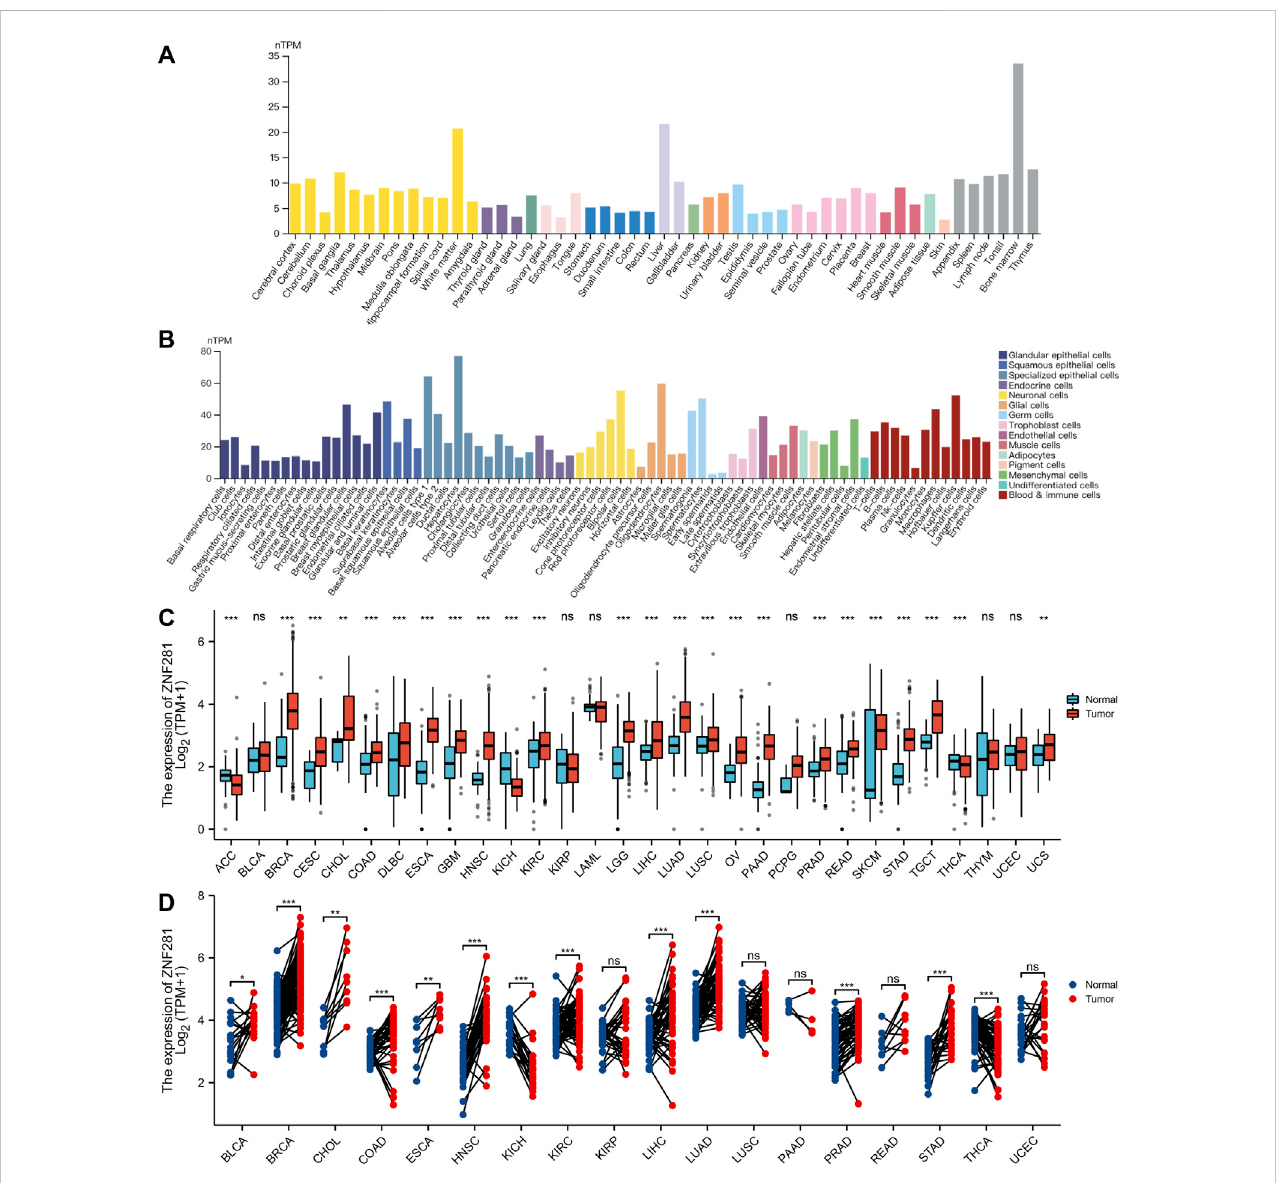
FIGURE 2 Expression levels of ZNF281 were higher in tumors and normal tissues. (A) ZNF281 expression in normal tissues, (B) ZNF281 expression in single-cell types, (C) ZNF281 expression was upregulated in most types of cancers than normal tissues, combining the data of TCGA and the GTEx database, and (D) ZNF281 expression in TCGA tumors and adjacent normal tissues (* p < 0.05, ** p < 0.01, and *** p <